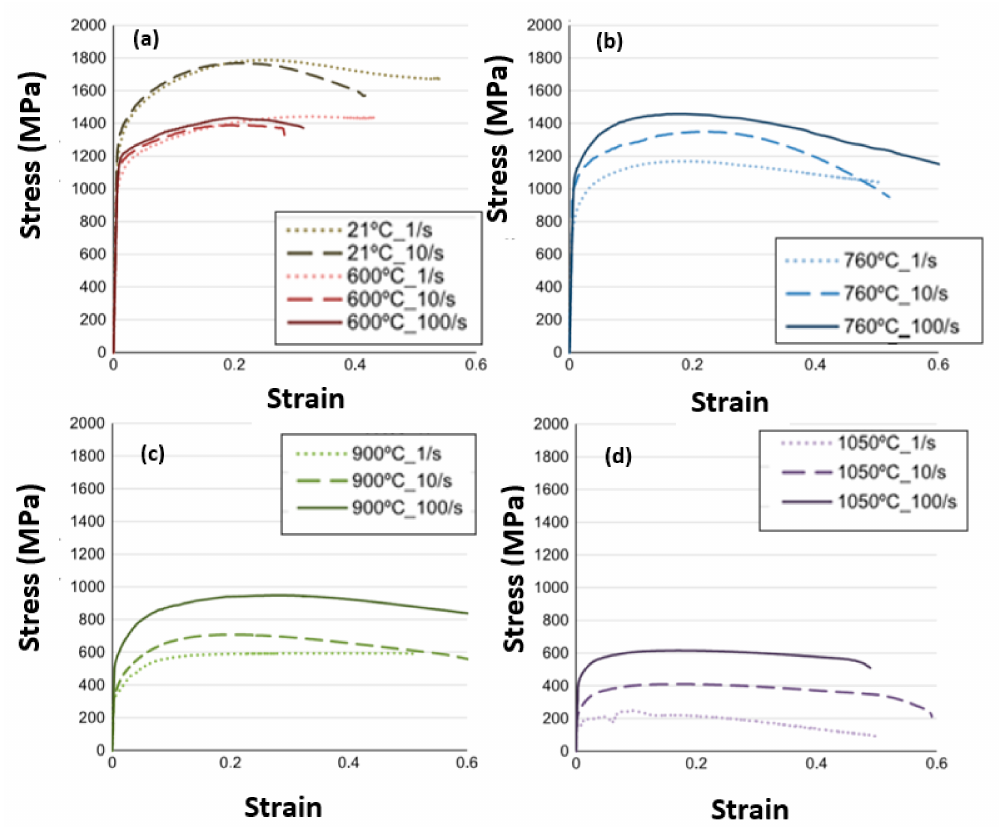
Figure 4. Flow stress behavior of Inconel 718, Temperature influence with respect to the various strain rates ( a ) Temperature of 21 ◦ C and 600 ◦ C; ( b ) Temperature of 760 ◦ C; ( c ) Temperature of 900 ◦ C and ( d ) Temperature of 1050 ◦ C (obtained from [25] with kind permission from Elsevier).